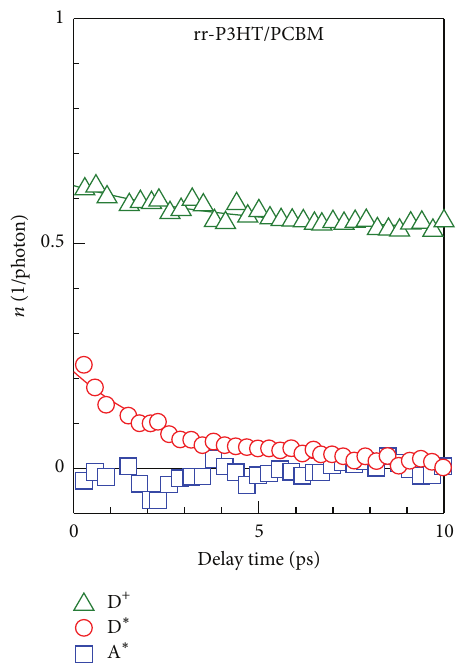
Figure 11: 𝑛 D + , 𝑛 D ∗ , and 𝑛 A ∗ per an absorbed photon against the delay time in rr-P3HT/PCBM blend film. Adjacent averages were plotted in 𝑛 A ∗ . The solid curves are results of the least-squares fittings with exponential